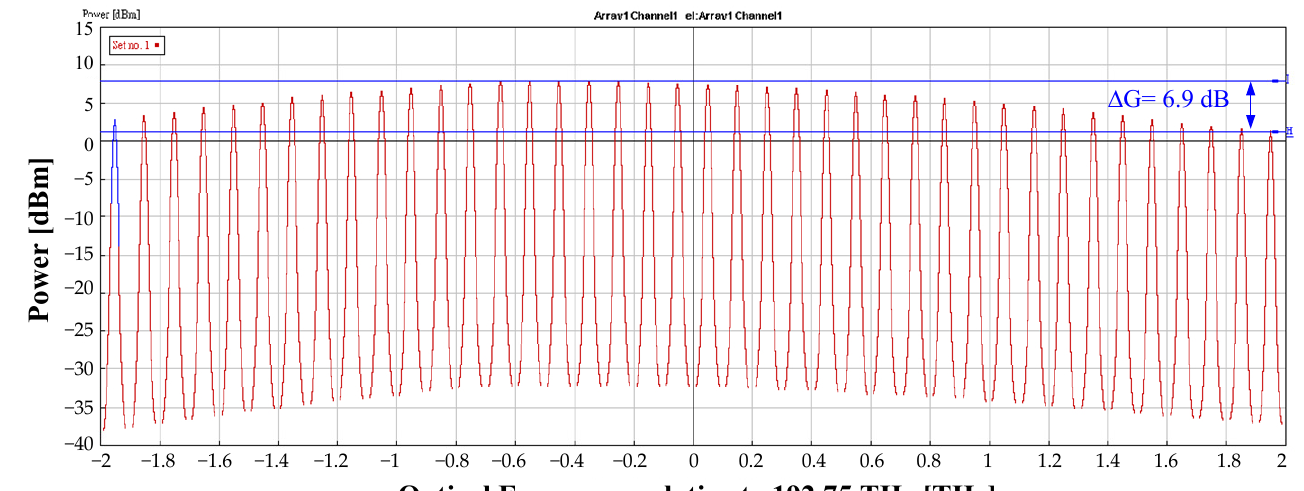
Figure 14. Gain flatness of the post-amplifier in ROA 3 . The BER curves of CH1 (190.8 THz, 1571.24 nm), CH20 (192.7 THz, 1555.75 nm), and CH40 (194.7 THz, 1539.77 nm) are shown in Figures 15–17, respectively. For a BER of 10 − 9 , the difference in the Rx sensitivities of these three channels is not obvious on a back-to-back (B2B) condition; the Rx sensitivity is approximately − 22.8 dBm. After transmitting via the SSMF, fiber dispersion has the most significant effect on CH1; the longest transmitted distance of CH1 is limited to 85 km, whereas that of the remaining two channels is up to 95 km. Moreover, fiber dispersion has the lowest influence on CH40, with it having lower the minimum required received optical power (ROP) of approximately − 20.08 dBm for a BER of 10 − 9 .